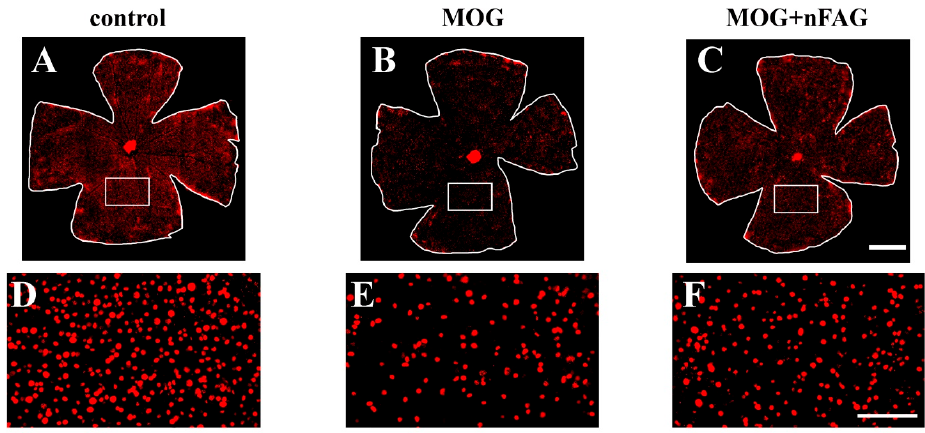
Figure 5. nFAG dietary supplementation reduces retinal ganglion cell (RGC) loss. Representative images of Brn3a-labeled RGCs in retinal whole mounts from control mice ( A ); MOG-treated mice without nFAG dietary supplementation ( B ) or MOG-treated mice with nFAG dietary supplementation ( C ) ( n = 4 for each experimental condition); ( D – F ) High magnifications views of the boxed areas in panels A – C . Scale bars: 1 mm ( A – C ) or 250 µ m ( D – F ).